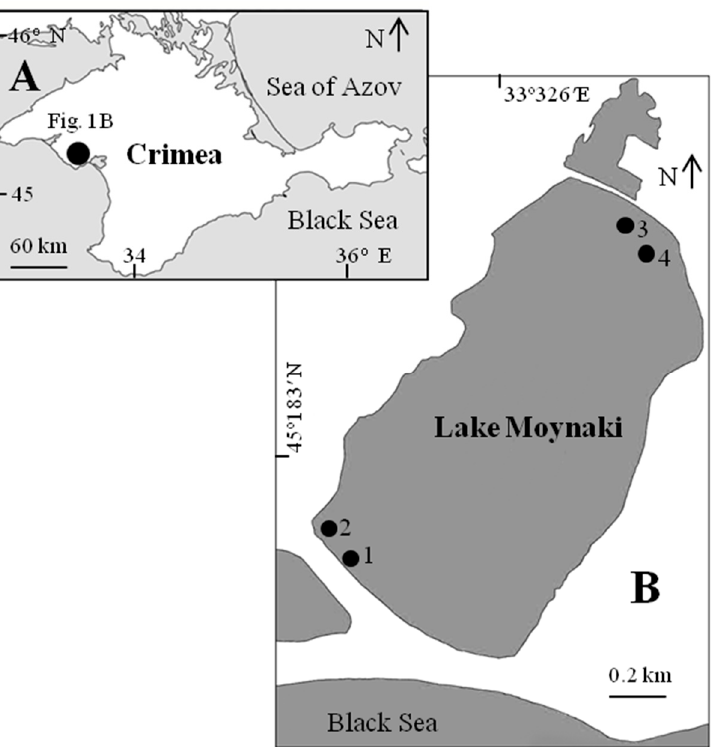
Figure 1. The scheme of Lake Moynaki and studied sites (( A ) the Crimean scale; ( B ) the Lake Moynaki scale). Sites 1, 2, and 3 were studied from 15 to 16 September, and site 4 was studied only once on 14 September (zooplankton and benthos).